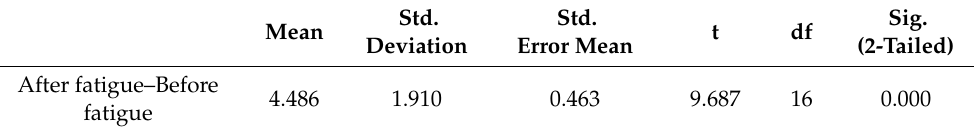
Table 8. Paired samples t -test result. Mean